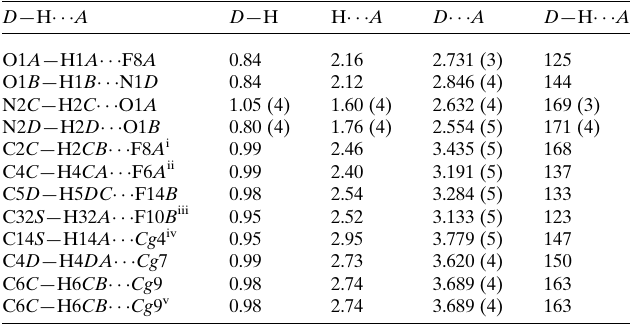
Table 1 Hydrogen-bond geometry (A˚ , (cid:5) ).